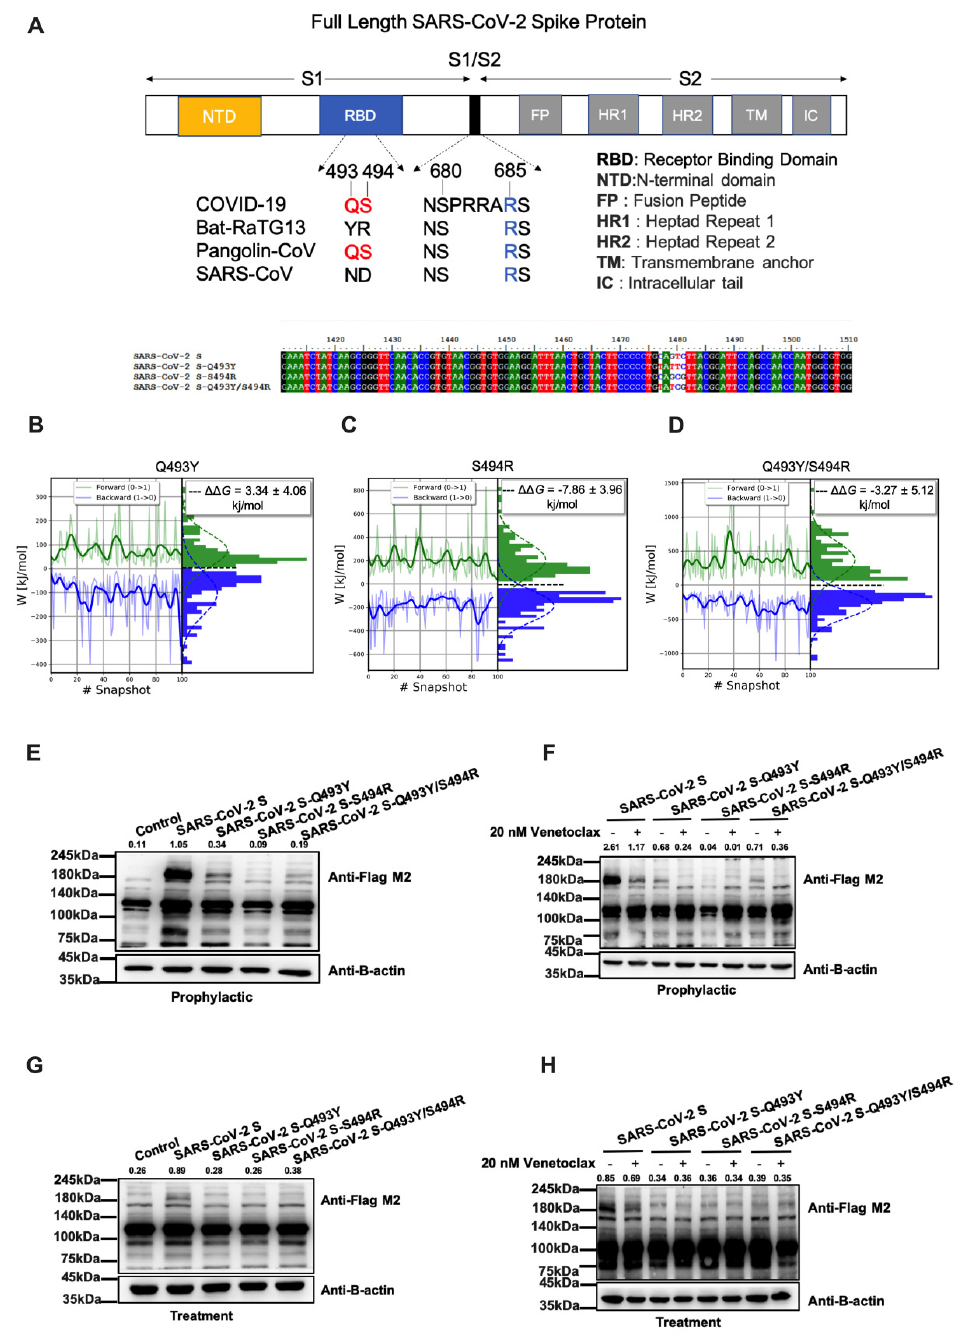
Figure 6. Analysis of the S1-RBD:Venetoclax binding free energy and the level of the SARS-CoV-2 spike protein through S494. ( A ) The sequence variation of various coronaviruses at positions 493 and 494. Distribution of the work values over time for an alchemical free energy simulation of ( B ) Q493Y, ( C ) S494R, and ( D ) Q493Y/S494R mutations. The left plot in each result shows the work values obtained from the integration of δ H λ / δλ as a function of the sampling time of the equilibrium states. The right plot in each result shows the histograms of work values from which the free energy was calculated. ( E – H ) Detection of the flag (180 kDa) by immunoblotting in cells overexpressed with 2 ug of SARS-CoV-2 S, SARS-CoV-2 S-Q493Y, SARS-CoV-2 S-S494R, and SARS-CoV-2 S- Q493Y/S494R plasmid, respectively. The total level of the flag of the spike protein was detected by immunoblotting. B-Actin was used as a loading control.